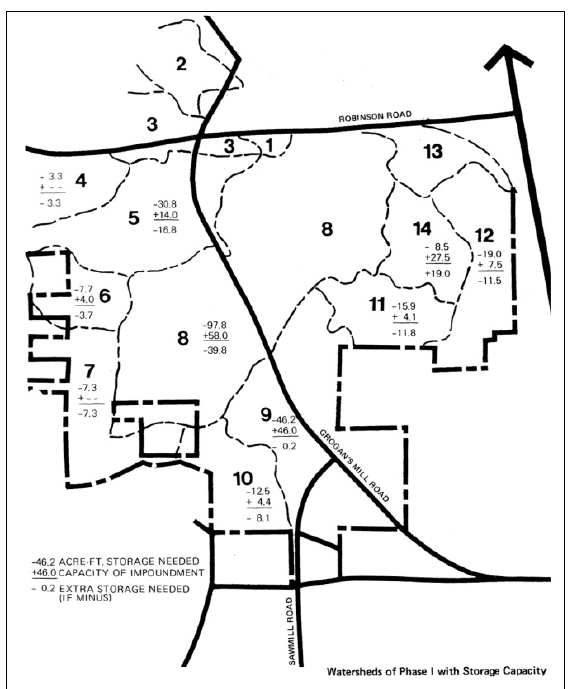
Figure 4. Modeling analysis on runoff storage in Phase I development (8 km 2 ), with no excessive runoff allowed ([50], p. 9) (Image courtesy: